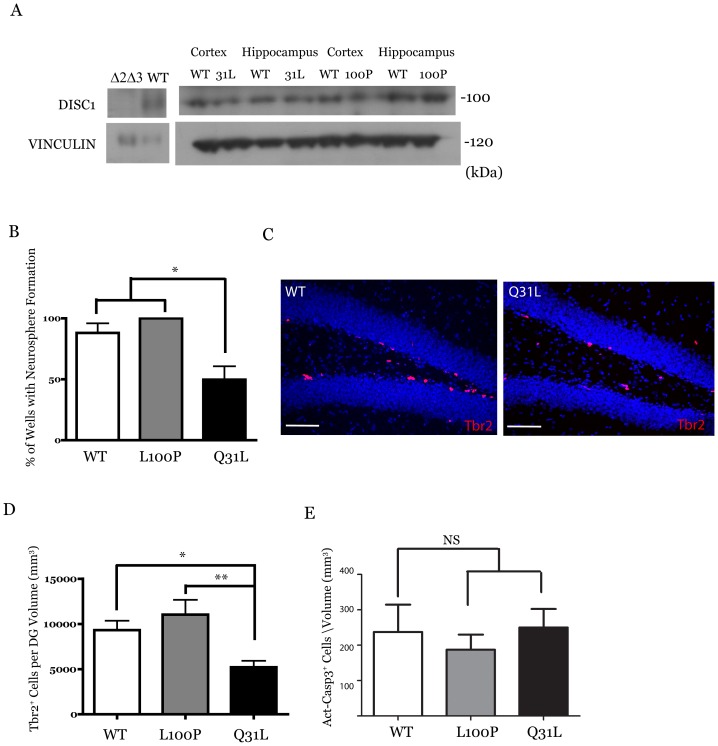
Deficits in cell proliferation are restricted to Disc1
31L/31L mice.(A) Missense mutations do not affect expression of full length DISC1 in tissue lysates taken from the cortex and hippocampus, as shown using a C-terminal DISC1 antibody that recognizes a specific 100 kDa band in the adult mouse tissue brain homogenates that are absent in Disc1
Δ2Δ3 mice. (B) Significantly fewer primary neurospheres (P = 0.007; post-hoc Bonferroni p<0.05) derived from dissociated adult hippocampal cells in Disc1
31L/31L mice (n = 6) compared with either wild-type (n = 6) or Disc1100P/100P (n = 4) mutants. (C) Confocal z-stacks of mouse sections labeled with an antibody raised against the neural progenitor marker Tbr2 (red) and nuclei label Hoechst 33242 (blue) indicate that Disc1
31L/31L mutants (n = 8) have significantly (D) fewer Tbr2 labelled cells (ANOVA, P = 0.014) than either wild-type (n = 9, post-hoc Bonferroni p<0.05) or Disc1
100P/100P (n = 9, post-hoc Bonferroni p<0.05) mice. (E) Cell death as measured by activated caspase-3 immunoreactivity was not significantly different between genotypes (ANOVA, p = 0.74, n = 4 wild type, Disc1
100P/100P; n = 5 Disc1
31L/31L; Scale bar 100 µm. Data presented as mean ± SEM.